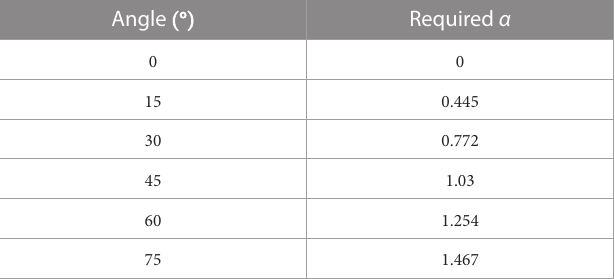
TABLE1 Therequired α fordifferentanglesfromthetheorypresentedinEq.